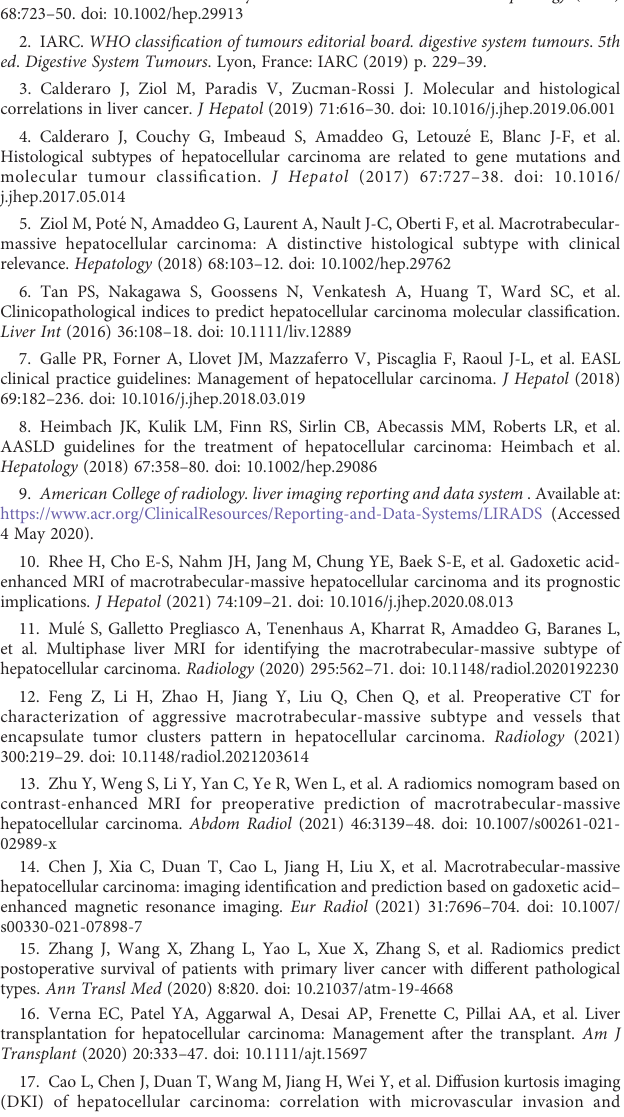
SUPPLEMENTARY TABLE 1 Clinical and Pathologic Features of Patients with Hepatocellular Carcinoma in the Primary and Validation Cohort. Note: Variables are expressed as median (interquartile range) or number of patients(percentage). Abbreviations: HBV=